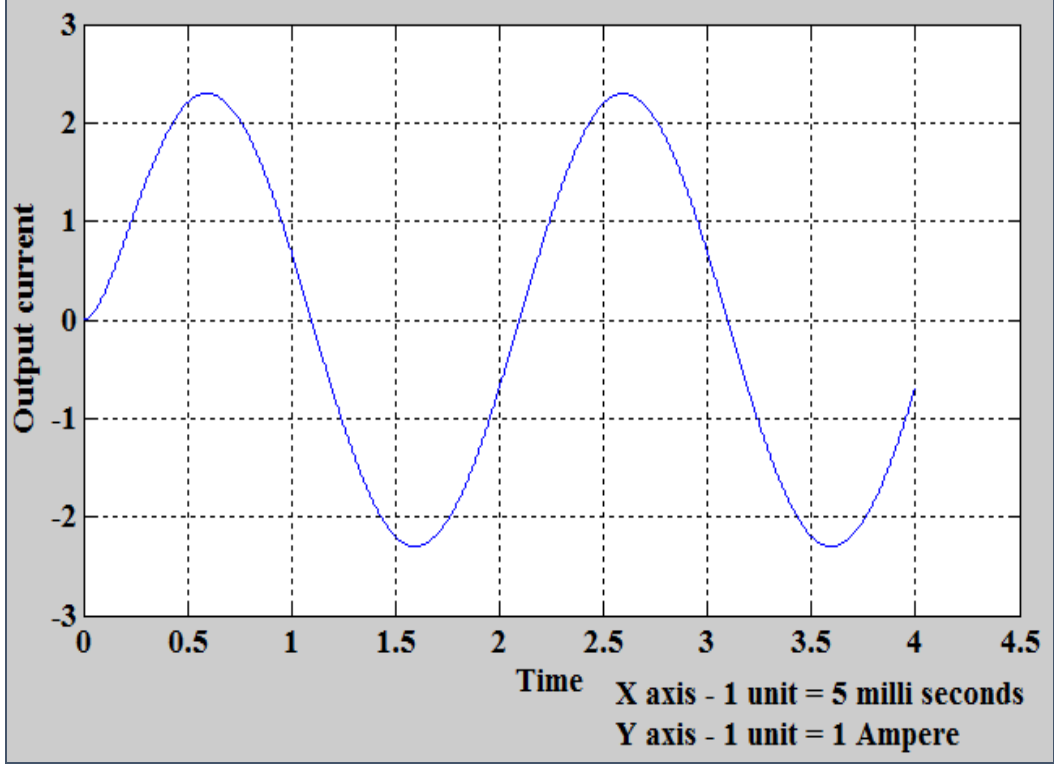
Figure 23. Output current vs. Time—RL load (100 + j31.4) ohm—Simulation.